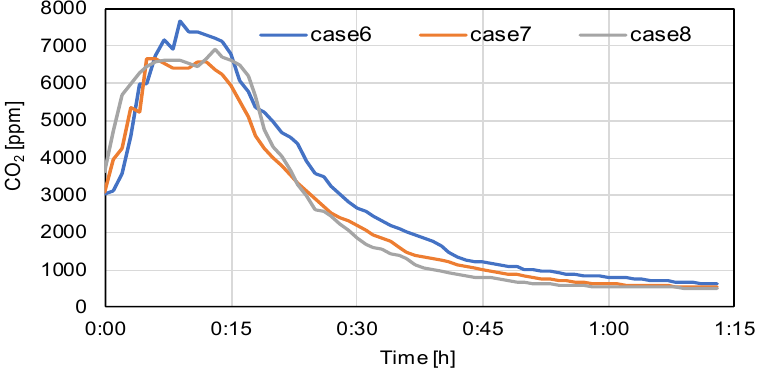
Figure 5. Carbon dioxide concentrations with use of a ventilation fan, natural ventilation, and an air conditioner (conditions 6–8).